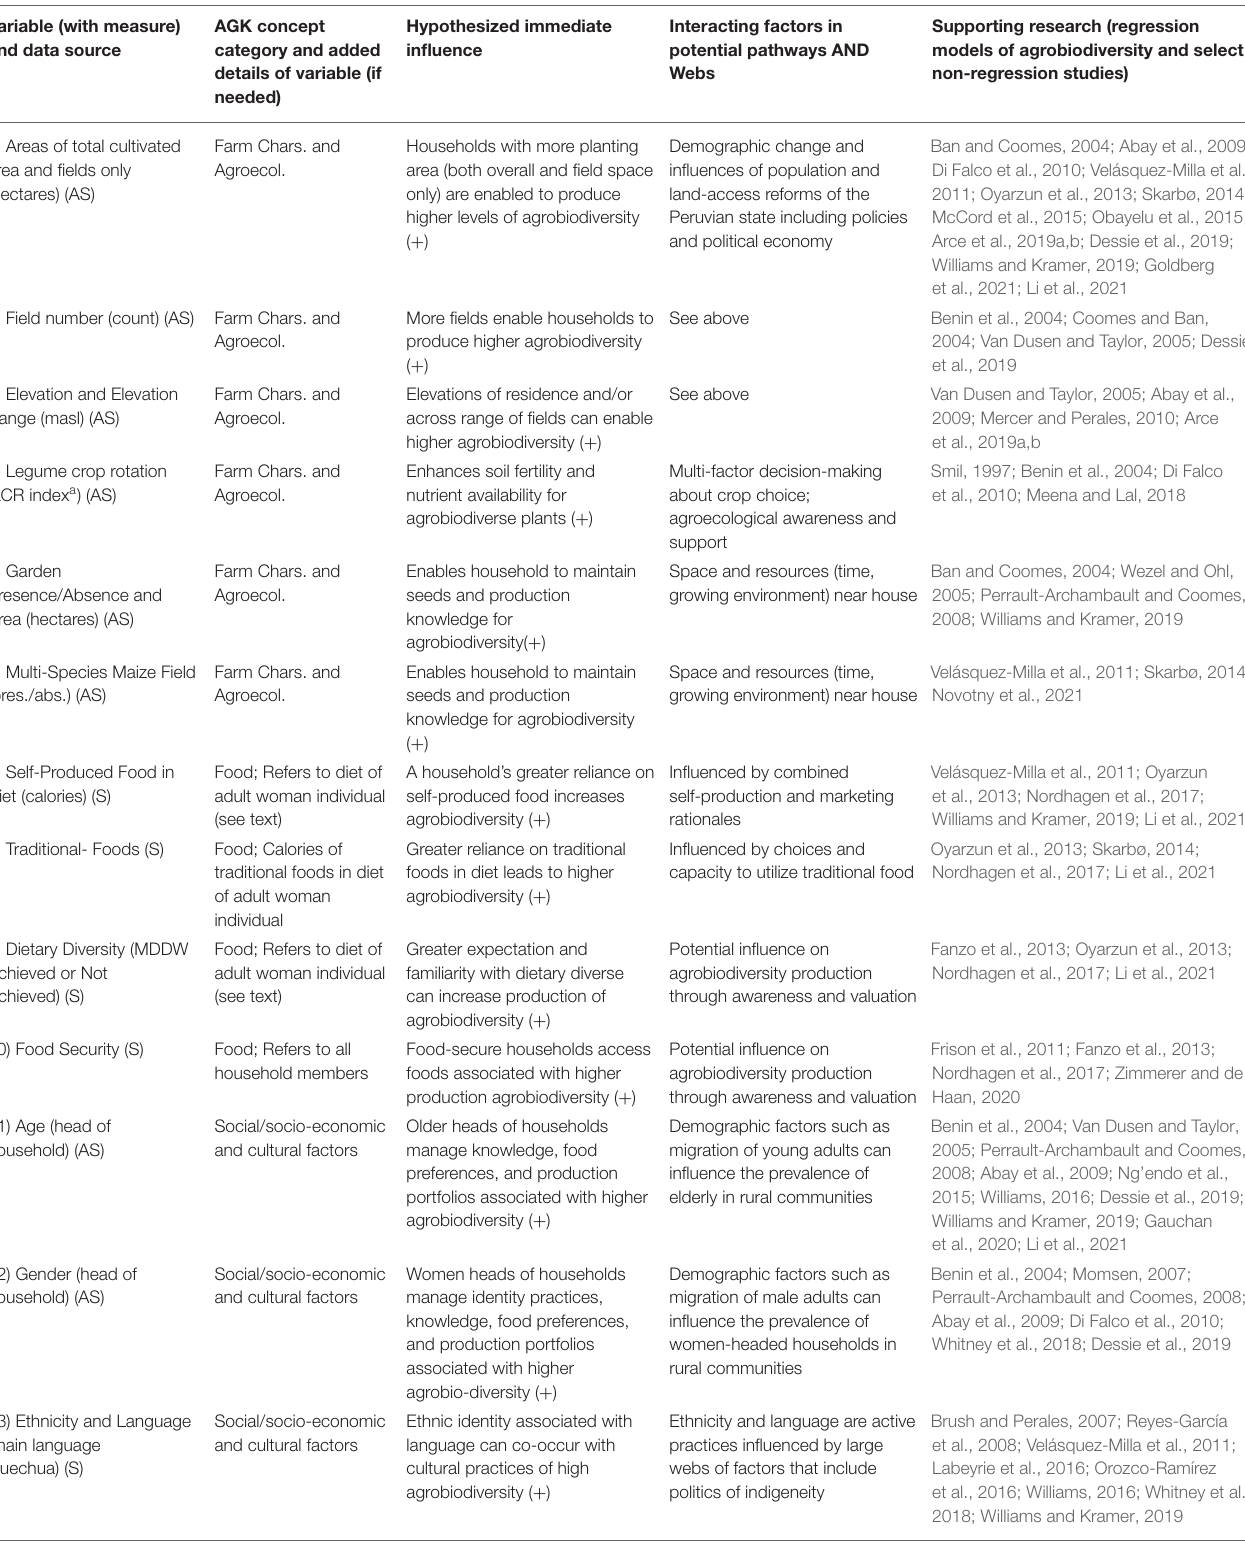
TABLE 1 | Hypothesized social-ecological and political-ecological determinants of agrobiodiversity based on the Agrobiodiversity Knowledge Framework (AKF); data sources for variables refer to survey as “S” and agrobiodiversity sampling as “AS” (descriptions in text). Variable (with measure) and data